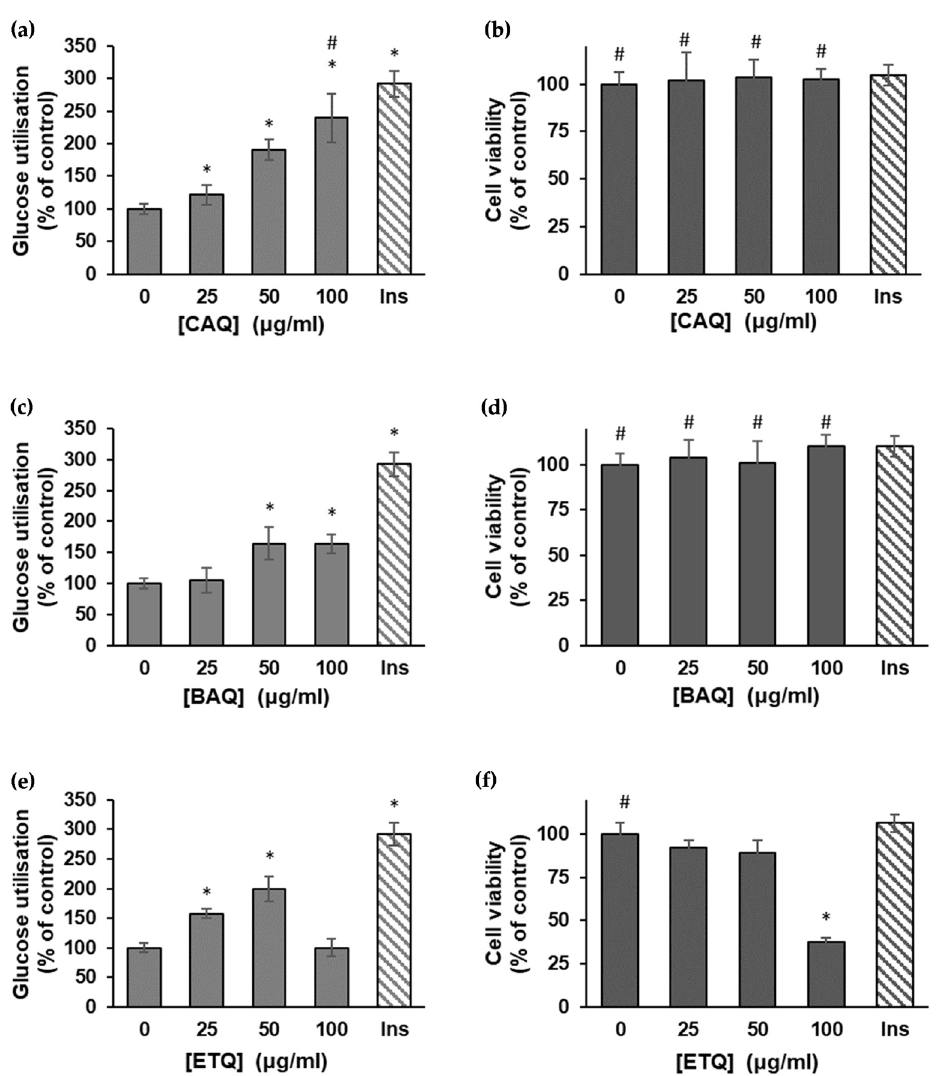
Figure 1. ( a ) Effect of the CAQ extract of H. petiolare on glucose uptake in L6 myocytes (data are expressed as mean ± SD, n = 3); ( b ) MTT cytotoxicity of the plant’s CAQ extract on L6 myocytes (data are expressed as % of control ± SD, n = 3); ( c ) effect of the BAQ extract of H. petiolare on glucose uptake in L6 myocytes (data are expressed as mean ± SD, n = 3); ( d ) MTT cytotoxicity of the plant’s BAQ extract on L6 myocytes (data are expressed as % of control ± SD, n = 3); ( e ) effect of the ethanol extract of H. petiolare on glucose uptake in L6 myocytes (data are expressed as mean ± SD, n = 3); ( f ) MTT cytotoxicity of the plant’s ethanol extract on L6 myocytes (data are expressed as % of control ± SD, n = 3). * Indicates a significant difference (p < 0.05) compared to the untreated control, and # indicates no significant difference relative to the positive control (insulin). BAQ, boiled aqueous; CAQ, cold aqueous; ETQ, ethanol; Ins,